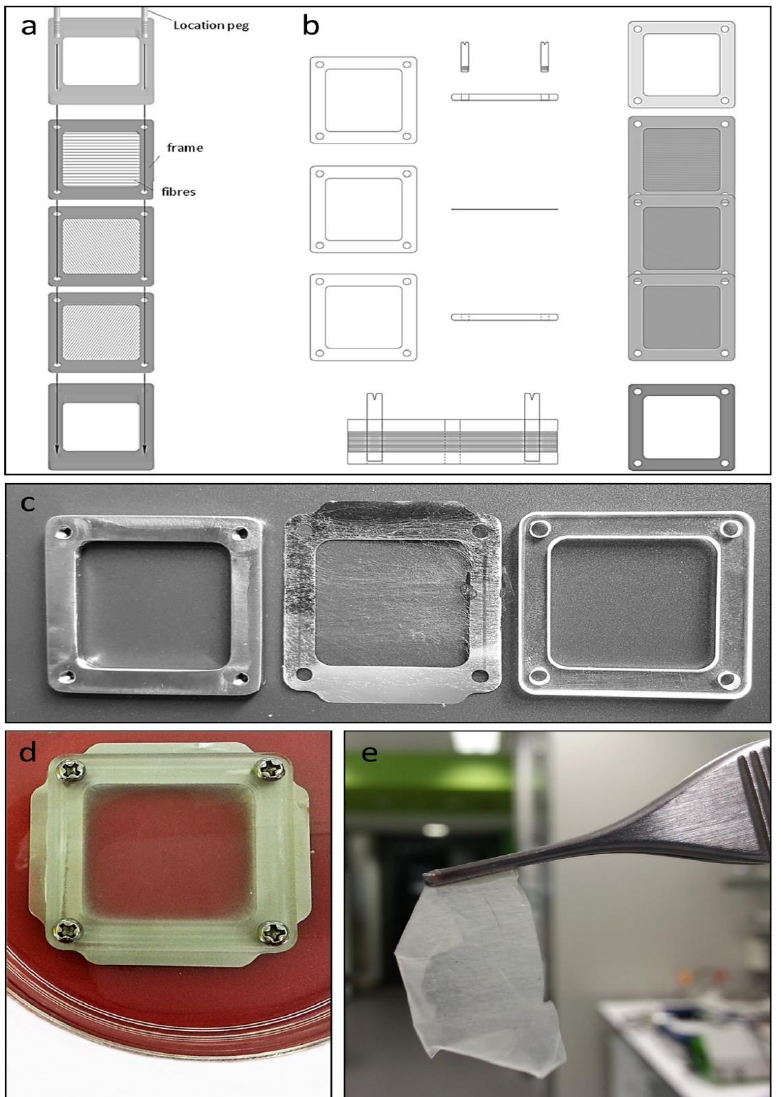
Figure 1. Layer frame construction. ( a , b ) Diagrammatic representation of support and layer frames with electrospun fibers. ( a ) Upper support frame is constructed of clear 3 mm thick Poly(methyl methacrylate) plastic, the middle 3 layer frames of 25 µm 304 grade stainless steel, and the lower support frame of 3 mm thick 304 stainless steel. Support frames are 4.4 × 4.4 cm overall. Fibers are deposited across stainless steel layer frames and used individually as substrates for cultured cells. Cells are seeded on the upper side of each layer frame and 24 h later, layer frames are turned over and seeded again. After a further 24 h, the seeded layer frames are stacked and sandwiched between the plastic support frame and the stainless steel frame using the location pegs (stainless steel) for alignment as shown in ( b ). ( c ) Left: lower support frame (304 stainless steel); middle: single stainless steel layer frame with electrospun PLG mesh; right: upper support frame (plastic). ( d ) Stacked layer frames (9 in total), seeded with cells and cultured for 7 days, im- mersed in culture medium in 100 mm culture dish. The stacked layer frames were constructed with two ( c ) or four ( d ) extension flanges, visible outside the margins of the support frames, to allow for handling with forceps. ( e ) Multilayered fiber and cellular skin sheet cut from stack of support and layer frames in ( d ), following 7 days in culture.